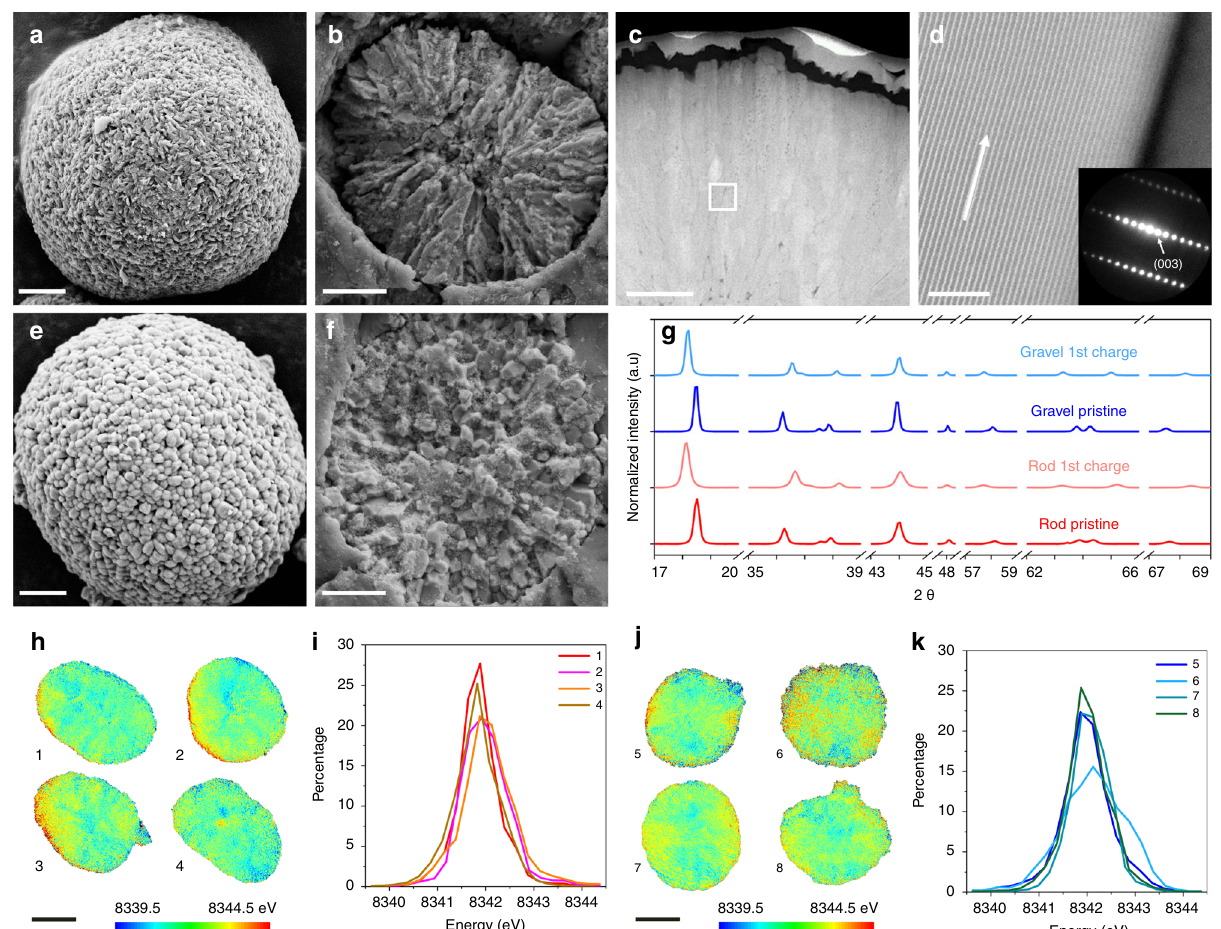
Fig. 1 Morphology, crystal structure, and charge distribution of the rod- and gravel-NMCs. a Overview and b interior SEM images of rod-NMC. c Cross- section and d high resolution STEM images of rod-NMC grains. Panel ( d ) corresponds to the square in ( c ). The nano-beam diffraction pattern of the fringes in ( d ) is included as an inset in ( d ). e Overview and f interior SEM images of gravel-NMC. g XRD patterns of rod- and gravel-NMCs in the pristine and the fi rst charged state (Cut-off voltage: 4.5 V vs Li + /Li; Current: C/5 (1C = 200 mA g − 1 ); Capacity: ~210 mAh g − 1 ). h 2D TXM images and i Ni K-edge energy histograms of four rod-NMC secondary particles in the pristine state. j 2D TXM images and k Ni K-edge energy histograms of four gravel-NMC secondary particles in the pristine state. The scale bars in ( a ), ( b ), ( c ), ( d ), ( e ), ( f ), ( h ), and ( j ) are 2 μ m, 2 μ m, 1 μ m, 5 nm, 2 μ m, 2 μ m, 5 μ m, and 5 μ m, respectively. The Ni K-edge energy in ( h ) and ( j ) are color-coded, where blue and red stand for low edge energy (low valence state) and high edge energy (high valence state),